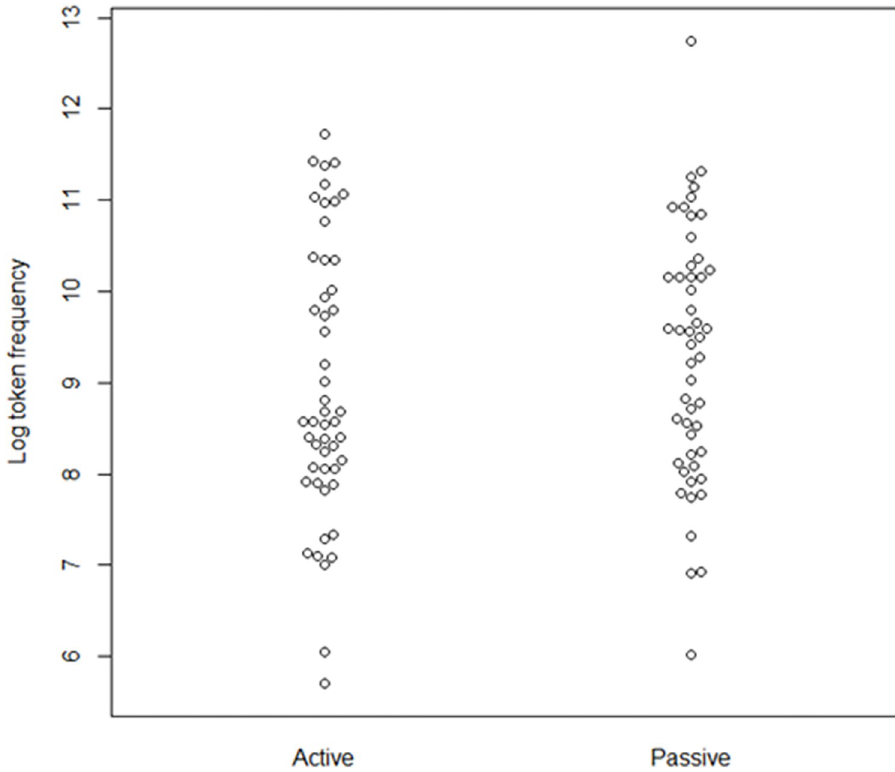
Fig 1. Beeswarm plot of log-transformed passive and active verb frequencies.